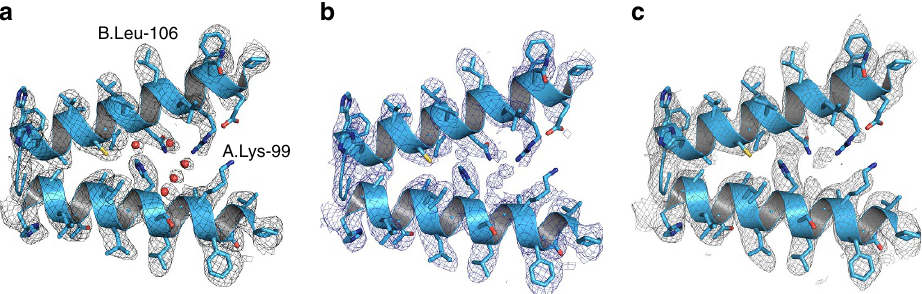
Figure 4 | Comparison of 3D density maps. Representative side-chain densities in reconstructions with ( a ) imposed C2 symmetry, ( b ) no imposed symmetry and ( c ) no imposed symmetry using a subset of 76,150 particles.